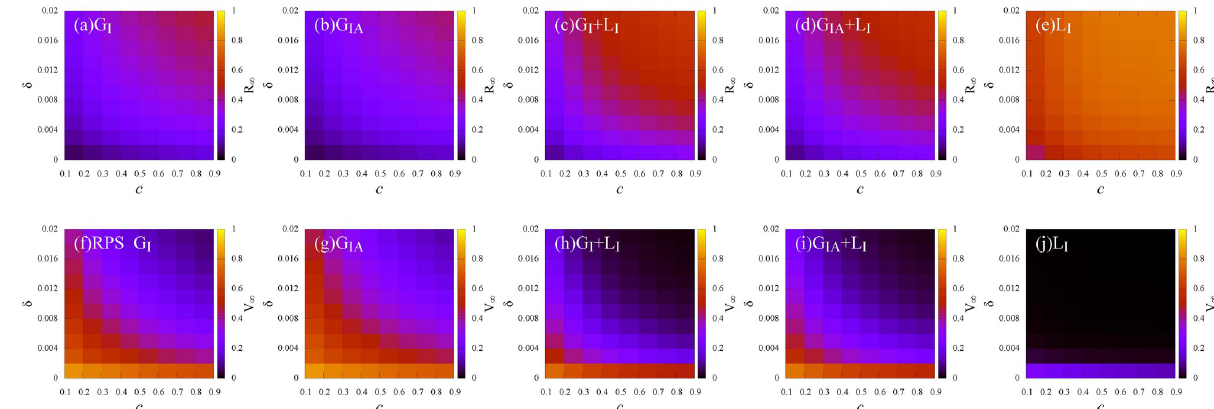
Fig 11. Effects of time-sensitivity of vaccine ( δ ) and cost ( c ) under different information sources. (a)—(e): R 1 , (f)—(j): V 1 . (a) and (f): Global information about infected individuals ( G I ); (b) and (g): Global information about infected and asymptomatic individuals ( G IA ); (c) and (h): Global information about infected individuals and local information about infected individuals ( G asymptomatic individuals with local information about infected individuals ( G IA + L I ); (e) and (j): Local information about infected individuals ( L I ). Here, the infection rate λ = 0.5.